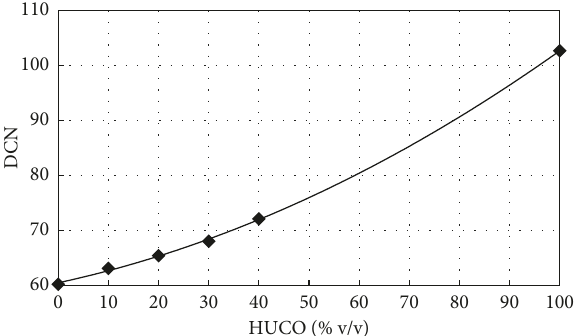
Figure 5: DCN values of ULSD, HUCO, and their blends, mea- sured by ASTM D7170 standard test method.